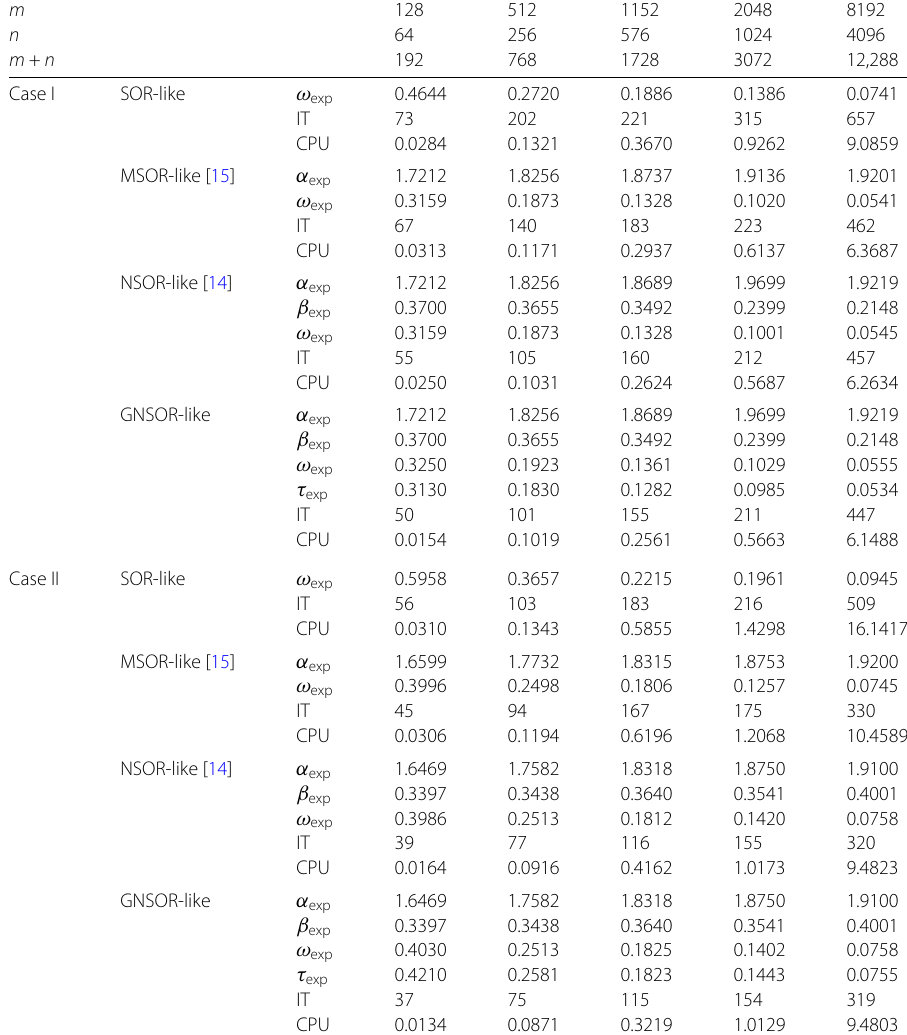
Table 2 ITs and CPUs of SOR-like, MSOR-like [15], NSOR-like [14], GNSOR-like, and NSSOR-like for Example